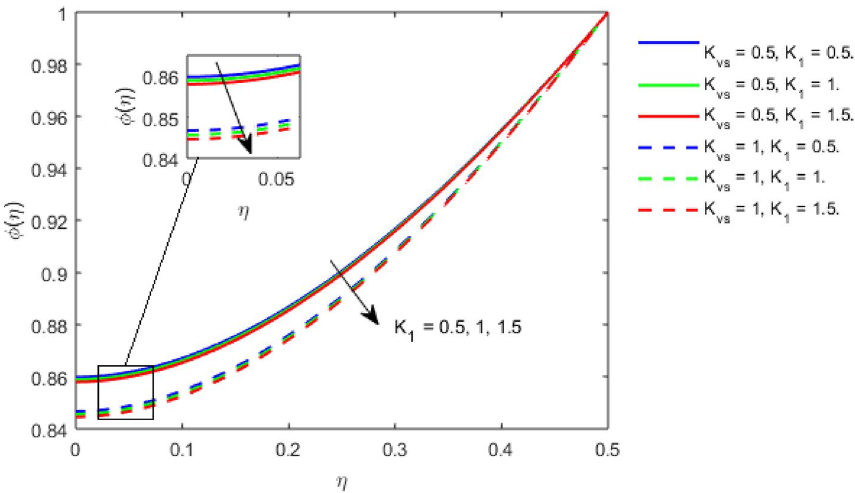
Figure 11. Concentration profile for increasing K 1 , and K vs , for Dilatant fluid by keeping thickness index m = 0.8 .